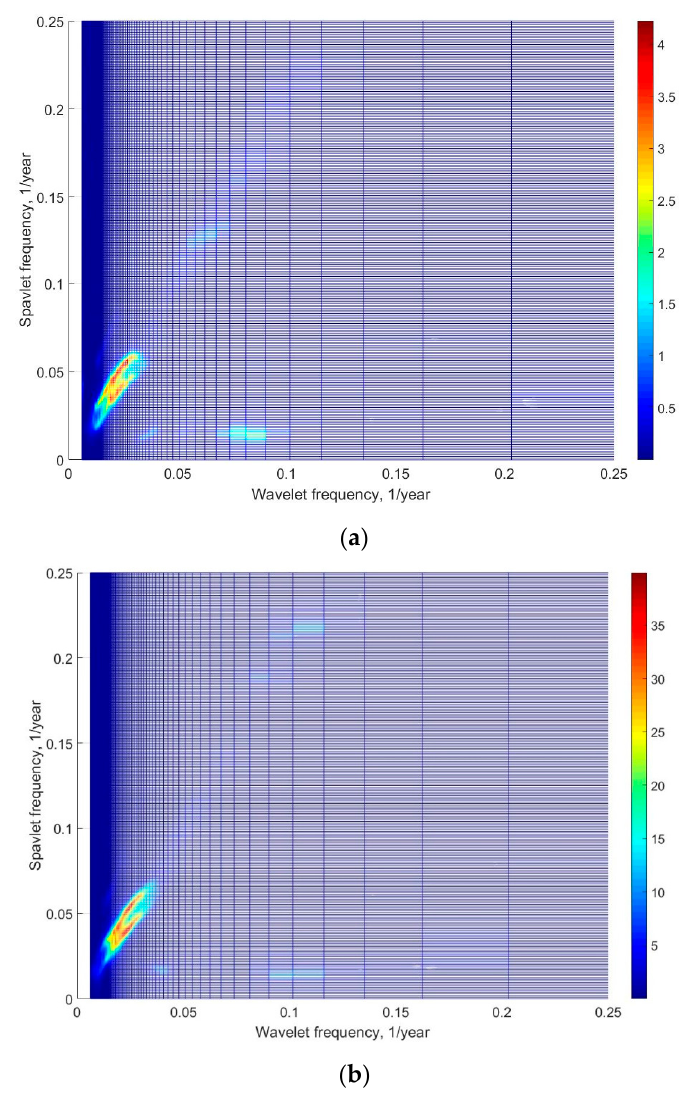
Figure 6. Spavlets of NAO ( a ) and PDO ( b ).